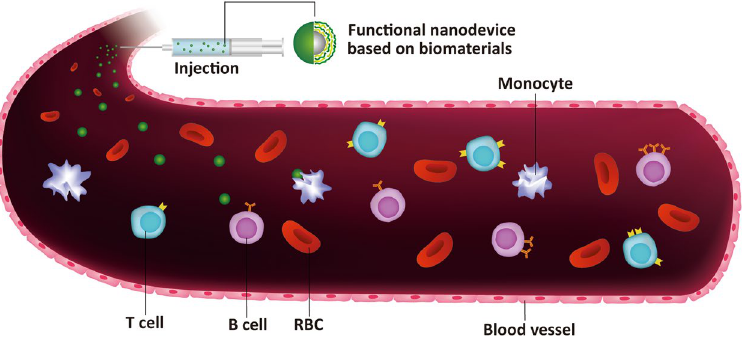
Figure 1. Scheme of the first stage of an in vivo study of functional nanodevices prepared from